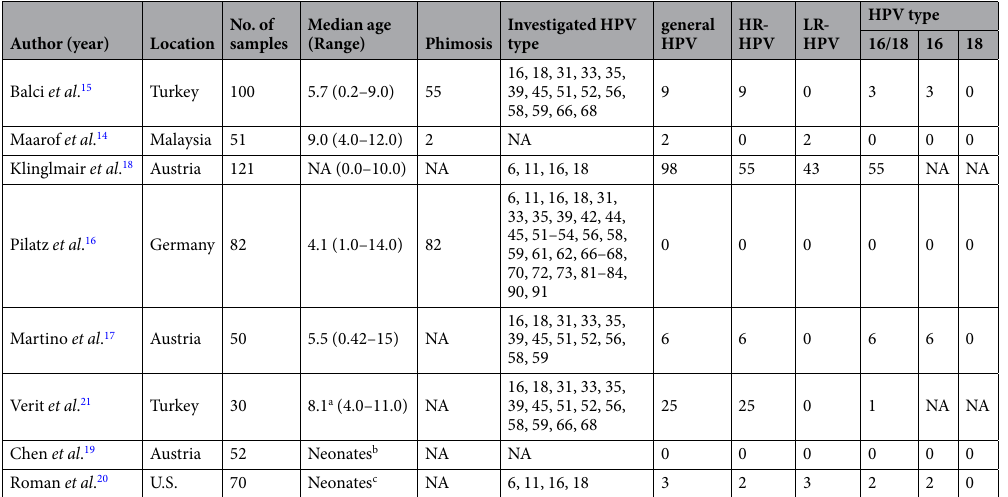
Table 1. Characteristics and results of the included studies. NA, not available; LR, low-risk; HR, high-risk. a Mean; b Sampled within hours of birth; c Sampled within 3 days of birth.